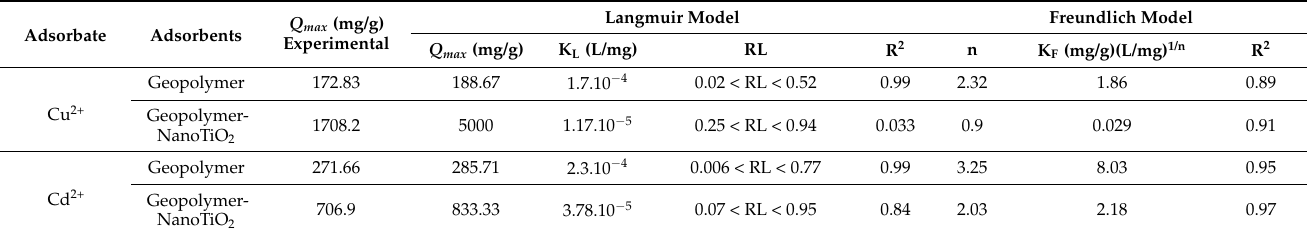
Table 3. Langmuir and Freundlich isotherm model